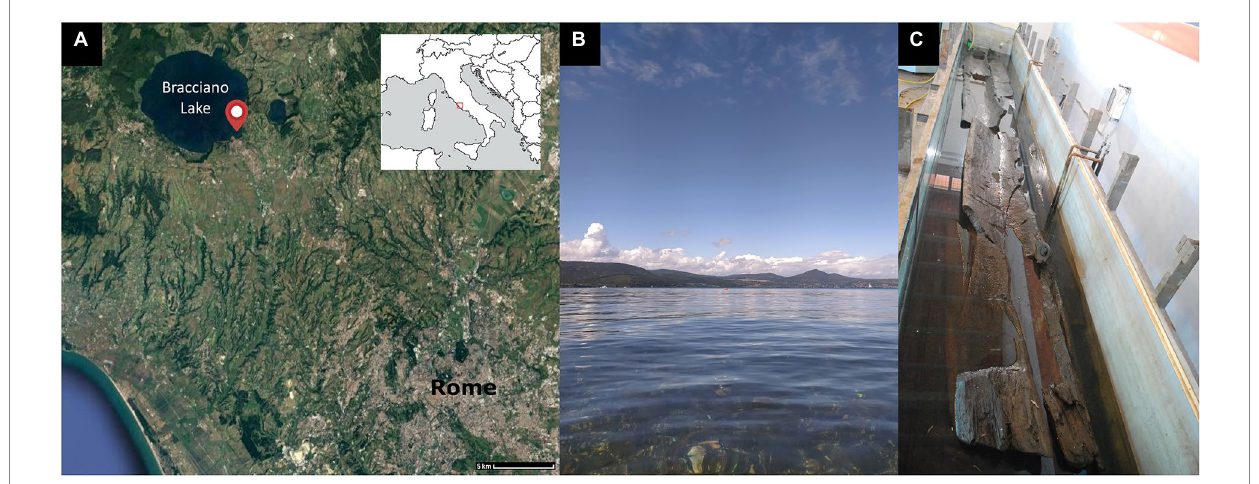
FIGURE 1 (A) The geographical location of the “La Marmotta” Neolithic site with respect to Rome, (B) the Bracciano lake, and (C) pirogue “Marmotta 5” in the storage tank at the “Anguillara Sabazia Neolithic Visitor